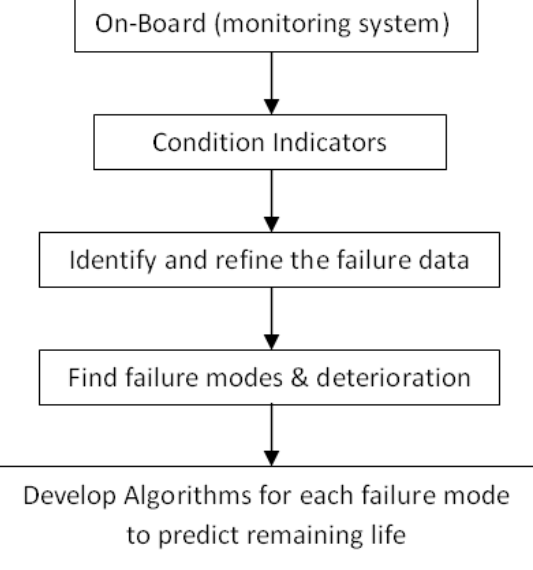
Figure 2. Failure algorithm steps.